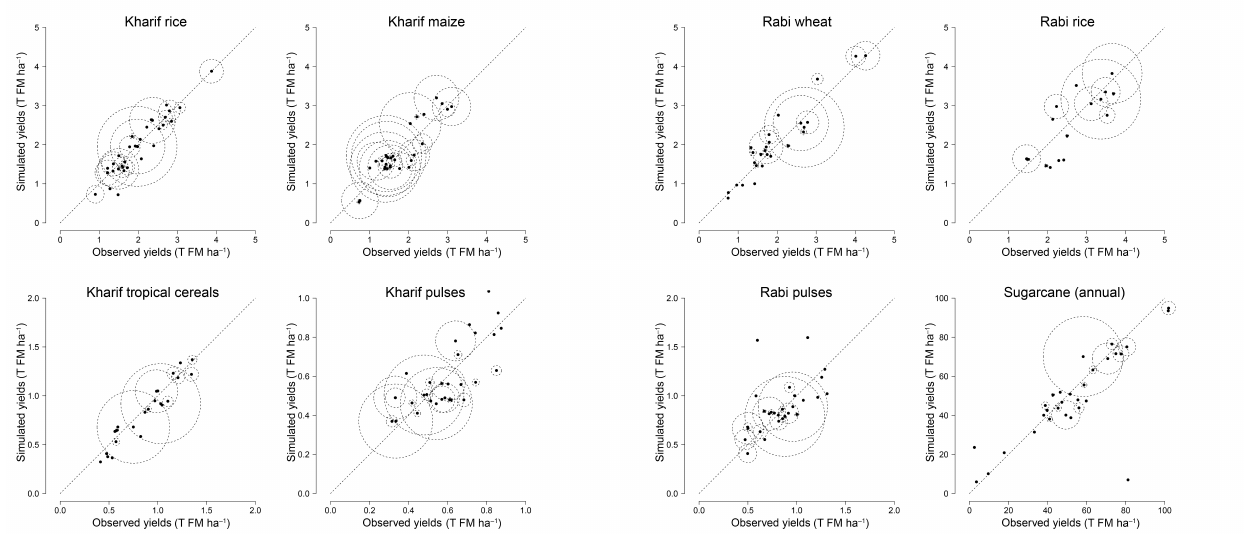
Figure 4. Observed vs. simulated (calibrated) crop yields for the most important crops in the different cropping seasons in tons of fresh matter per hectare ( T FMha − 1 ). Each dot represents one state (India), province (Pakistan) or country (Nepal, Bangladesh). Size of the circle represents the relative area under that crop (for areas, see Figs.